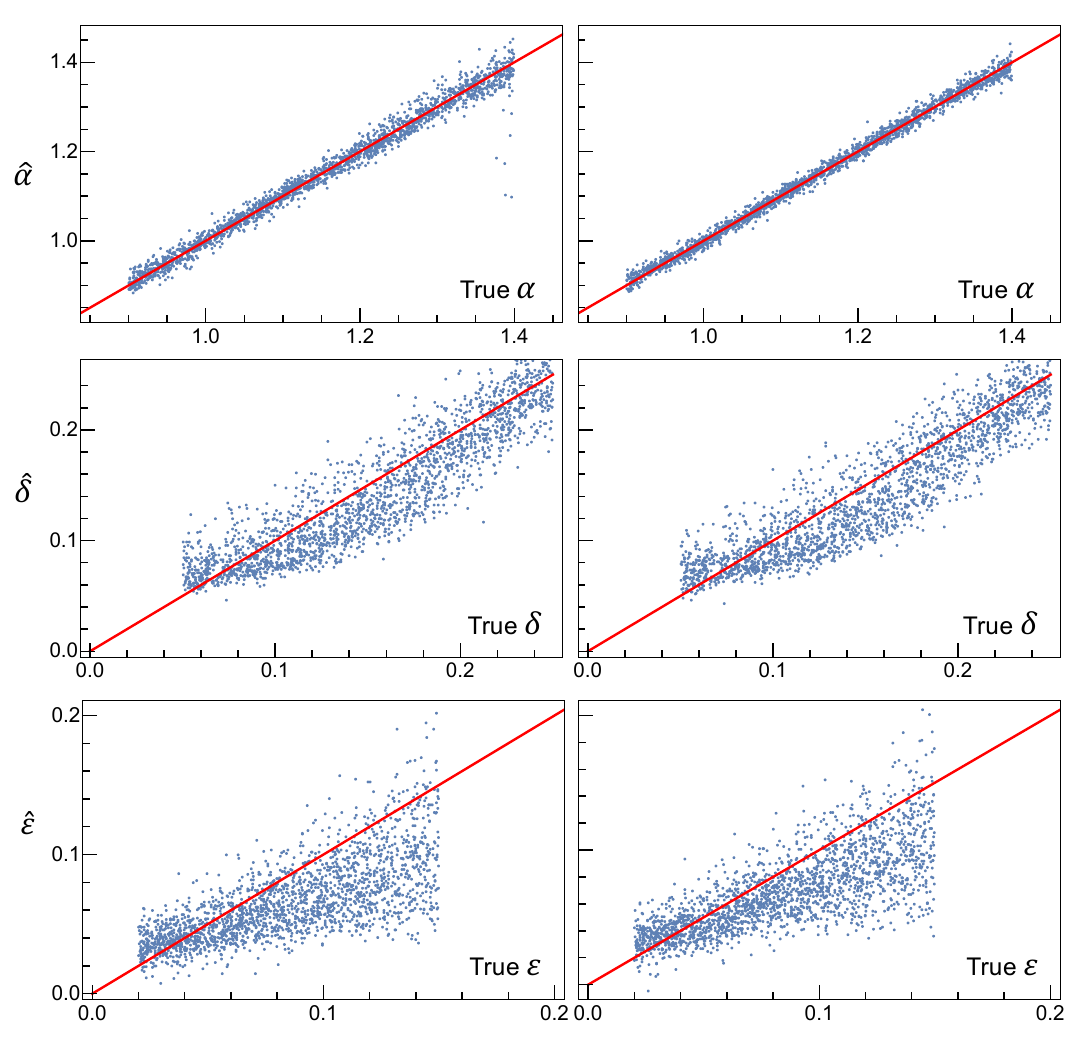
Figure 7: Parameter regression for model (13) from ENCA, using three (left column) or four (right column) latent variables. The contribution of the additional feature to the α -marginal is small but noticeable. (Results are similar for INCA.)